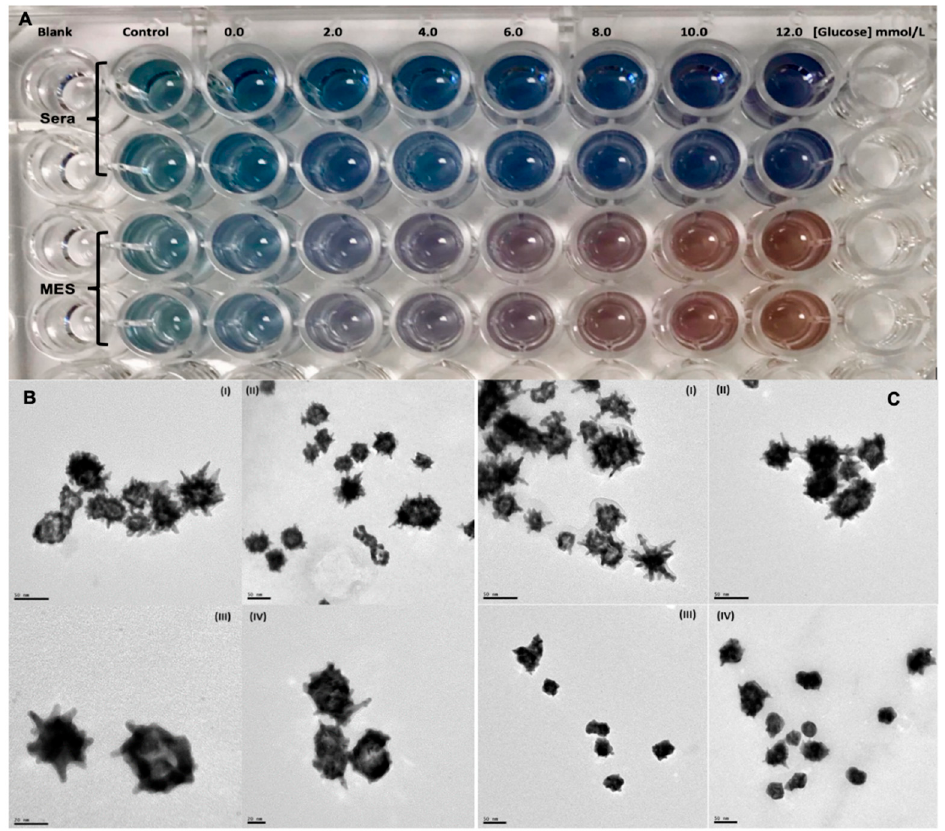
Figure 4. ( A ) Photograph for colour change of detection solution upon incubation with glucose in the AuNSs–Cys–GOx solution for 45 min; ( B ) TEM images in serum and ( C ) in MES buffer, (I) control AuNSs, (II) 0, (III) 6, (IV) 12 mmol / L